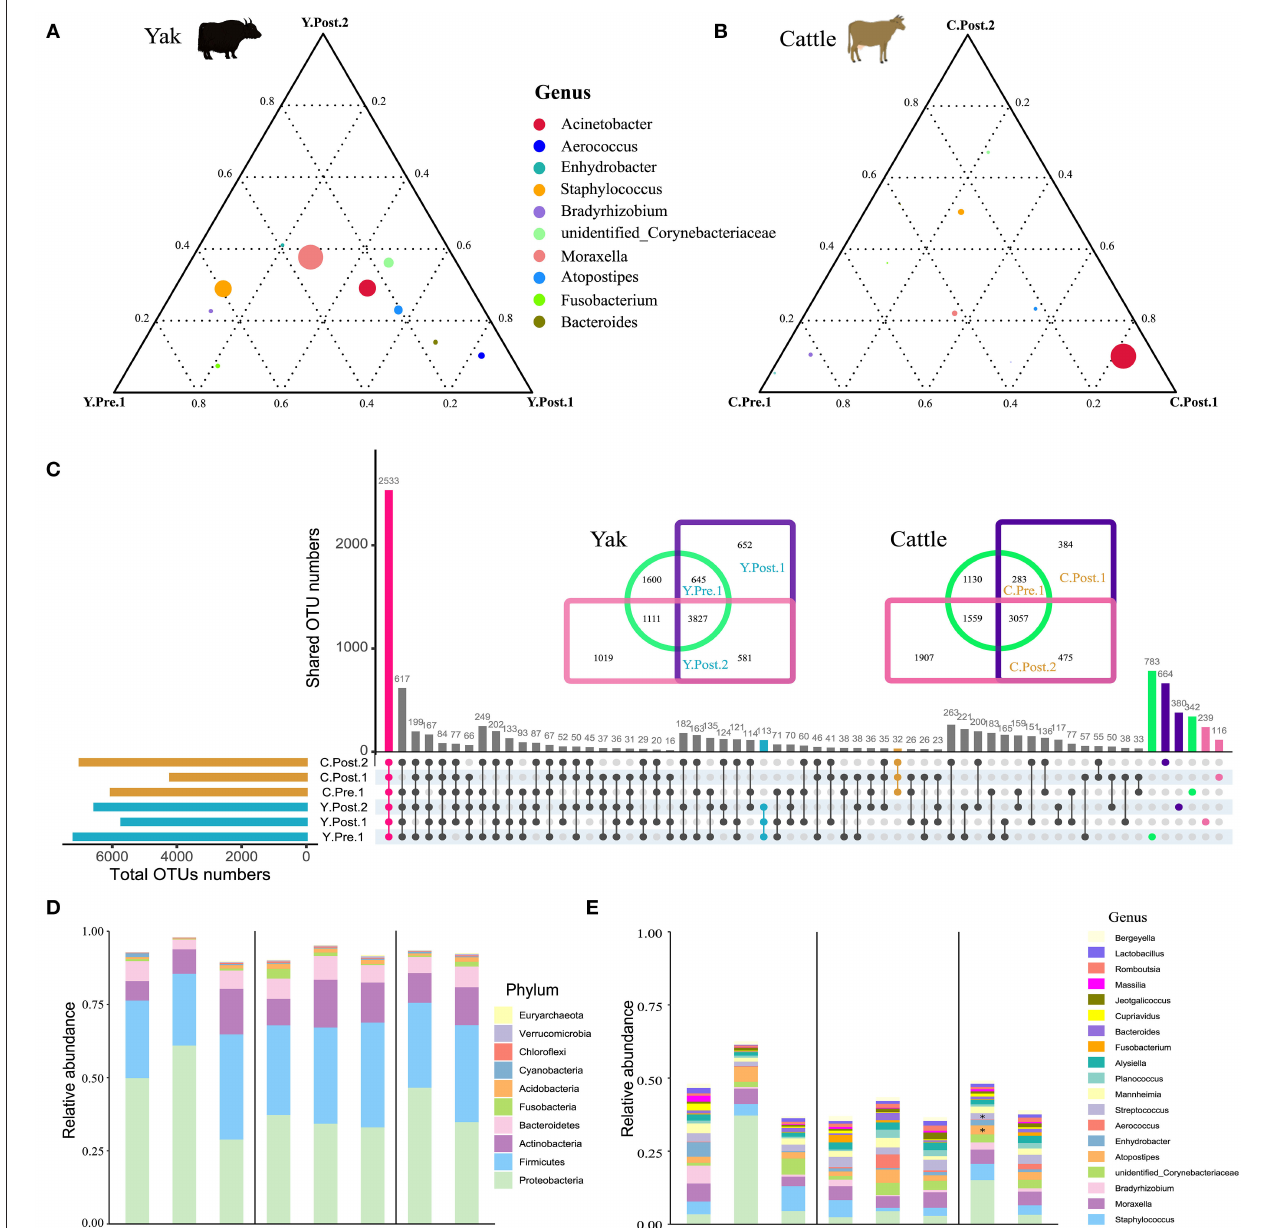
FIGURE 2 | Structure analysis of the core microbial community in udder skin of yak and cattle. The ternary plot command in the vcd package of R software was used to plot the ternary plot at the genus level (top 10) of udder skin microbiota of yak (A) and cattle (B) at different periods during the perinatal period. The three vertices in the figure represent the sample groups of three different time periods, and the circle represents the species. The size of the circle is proportional to the relative abundance. The closer the circle is to the vertex, the higher the content of the object in this group. (C) In order to find the OTU structure of the core microbiota of bovine udder skin, the OTU sharing of all the udder skin microbiota of yak and cattle in different periods during the perinatal period was plotted by upset command of UpSetR package of R software. Using jvenn online (27), OTU concentrations of microbiota in the skin of the respective udders of perinatal yak and cattle were mapped. The bar chart shows the composition of the core microbial community at (D) phylum and (E) genus levels in the skin of the udder of cattle (left), yak (middle), and mean values of both breeds (right). Significant changes are represented by an asterisk ( T -test, * p <